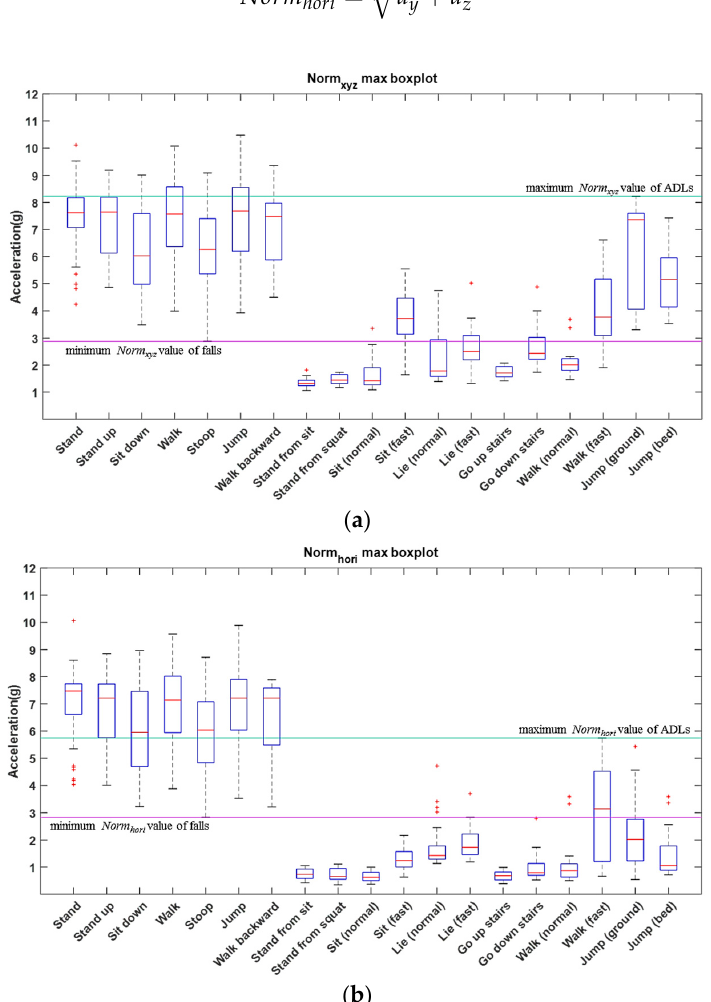
Figure 3. The illustration of the Norm xyz and Norm hori distribution of falls and ADLs. The left seven activities are falls and the right 12 activities are ADLs. The green line is determined by the maximum Norm xyz value of ADLs. The purple line is determined by the minimum Norm xyz value of falls. ( a ) The boxplot of maximum Norm xyz values for falls and ADLs; ( b ) The boxplot of maximum Norm hori values for falls and ADLs.